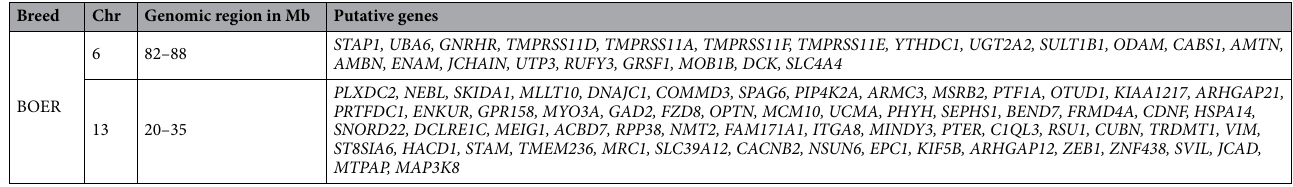
Table 3. List of candidate genes retrieved inside the genomic regions included in the interval of 1 Mb on both sides of ROH islands detected by detectRUNS.